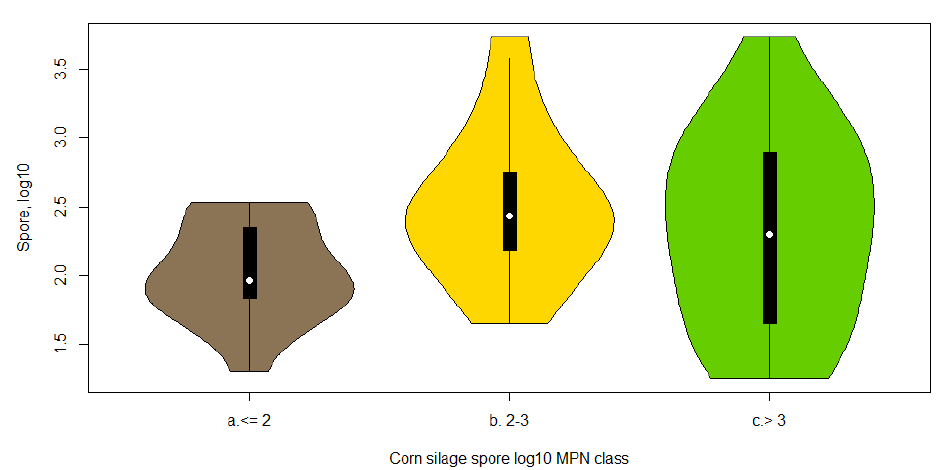
Figure 8. Distribution of anaerobic spore-forming bacteria spores (MPN, log 10 n/L) in bulk milk tanks from farms in three different classes of maize silage spore MPN (log 10 n /g) sampled within the study.